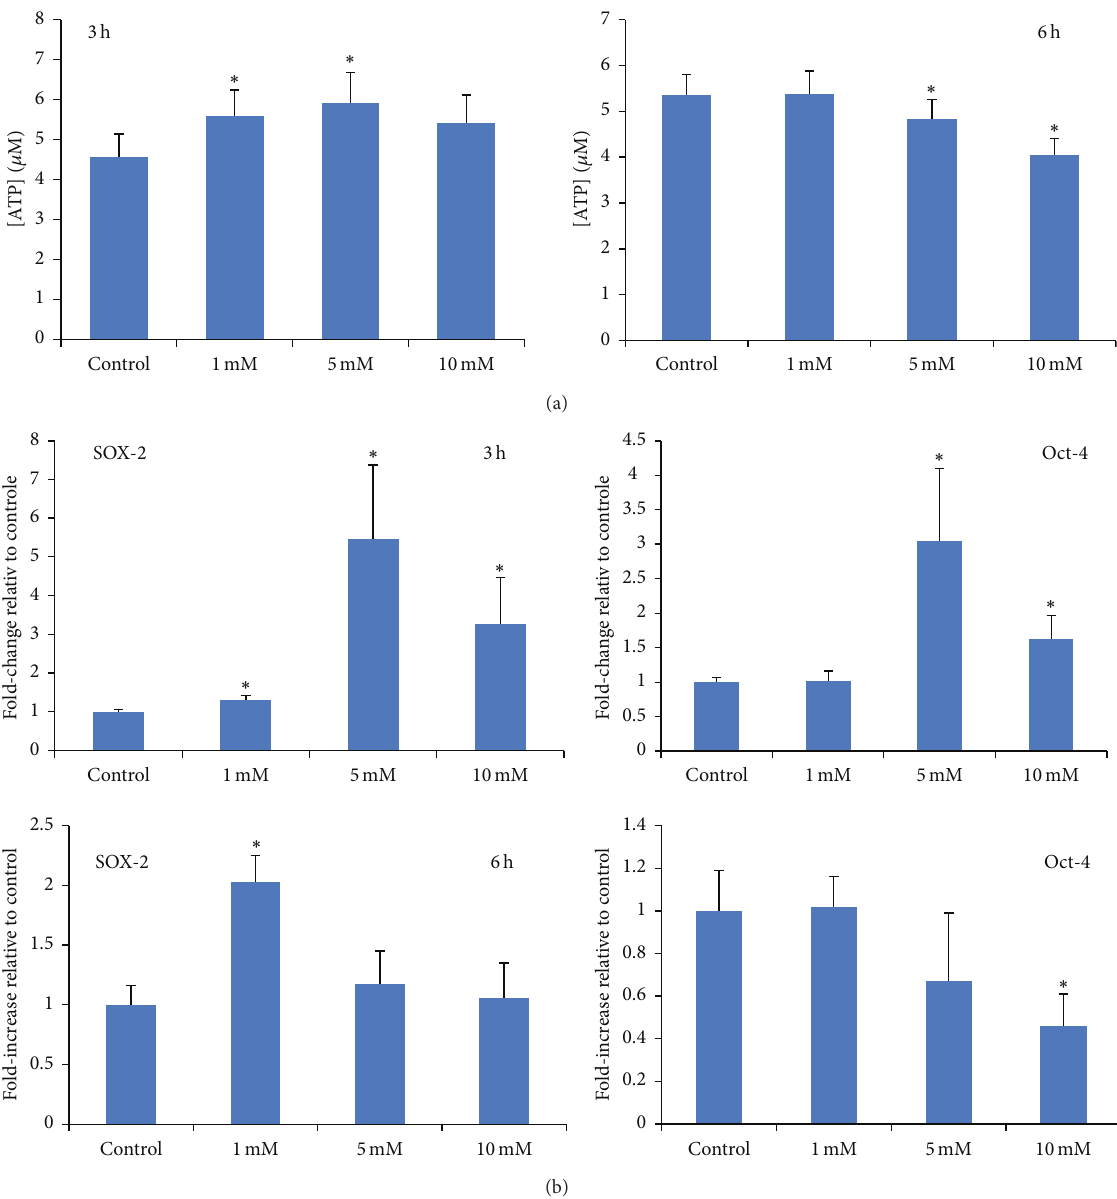
Figure 4: VPA exerts different effects on MSC proliferation and expression of pluripotency markers. (a) Cell proliferation was assayed by measuringtheintracellularATPreleasedbyCB-derivedMSCafterpretreatmentwithorwithout(control)1,5,or10mMVPA.Theexperiment was performed twice using 6 replicate wells per condition, and ∗ 𝑃 < 0.05 indicates statistically significant difference relative to control. (b) The expression of the pluripotency genes SOX2 and Oct-4 was evaluated by qRT-PCR using 18S mRNA as internal calibrator. The data is representative of two independent experiments and ∗ 𝑃 < 0.05 indicates statistically significant difference relative to